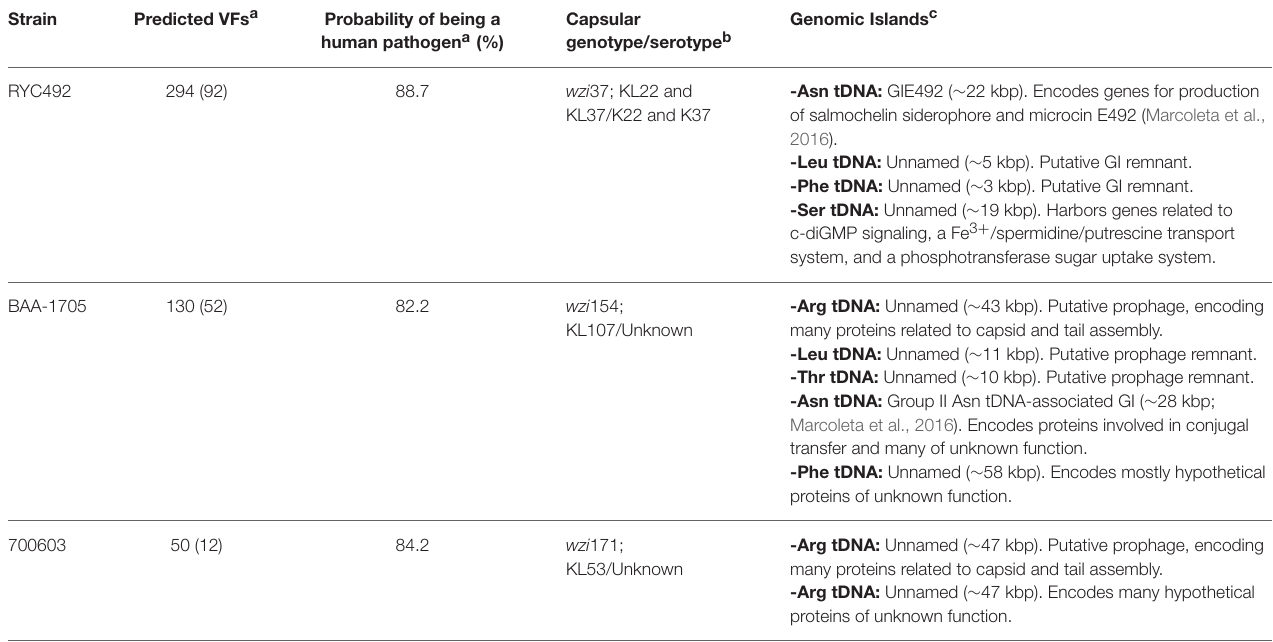
TABLE 2 | Main genomic features of K. pneumoniae strains used in this study.